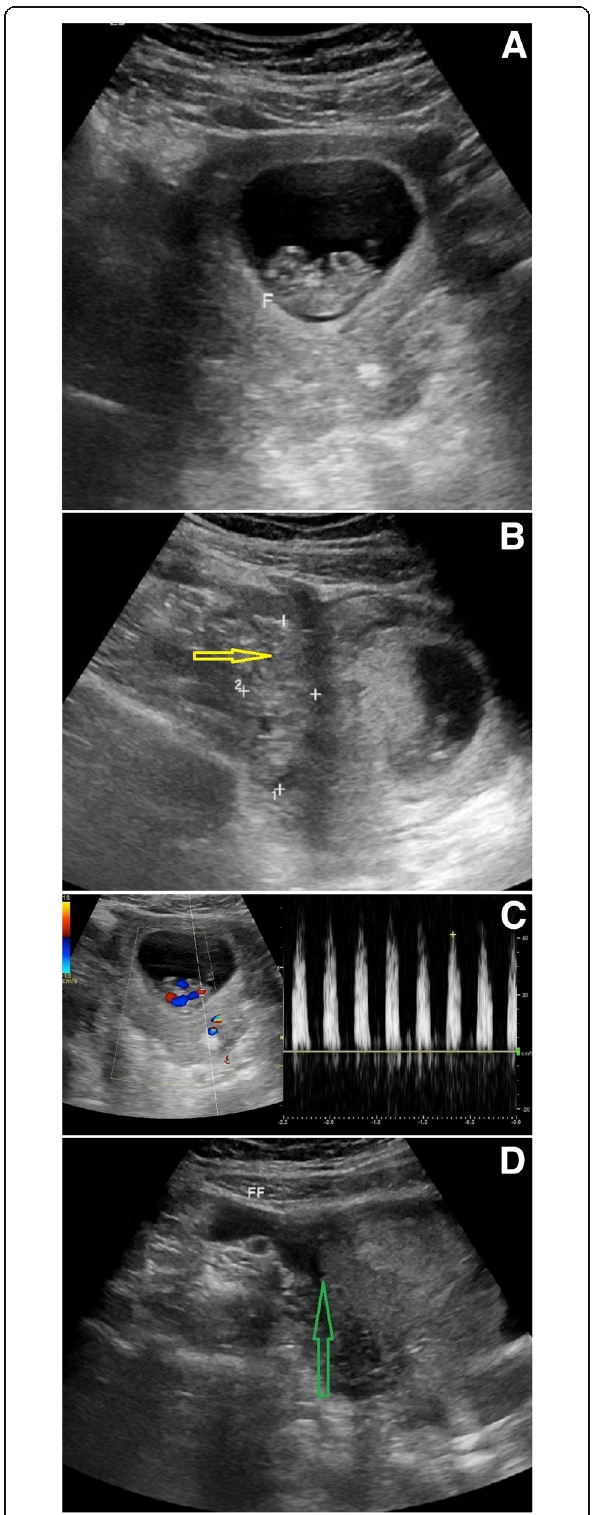
Fig. 1 a – d Ultrasound study shows the intrauterine fetus with cardiac pulsation and heterogenous right adnexal mass (yellow arrow), and pelvic fluid collection (green arrow) is